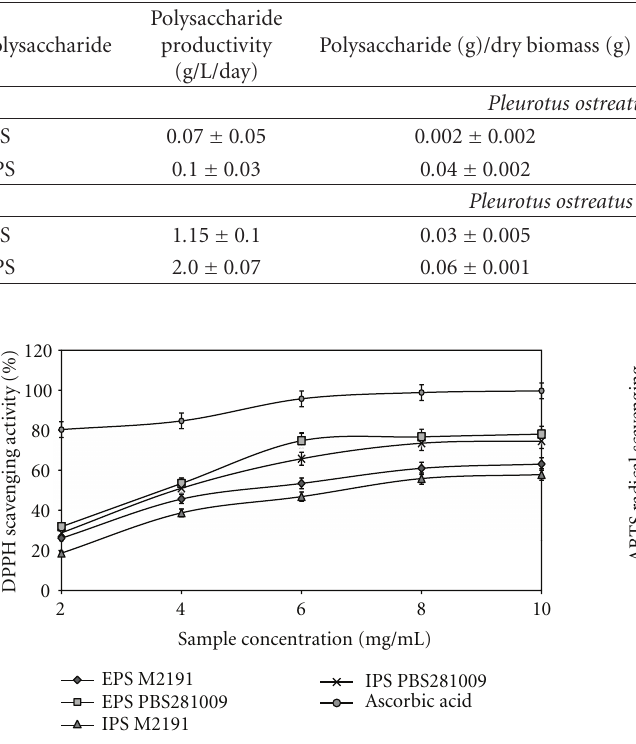
Figure 4: Scavenging e ff ect on ABTS radical of EPS and IPS from submerged culture of Pleurotus ostreatus M2191 and